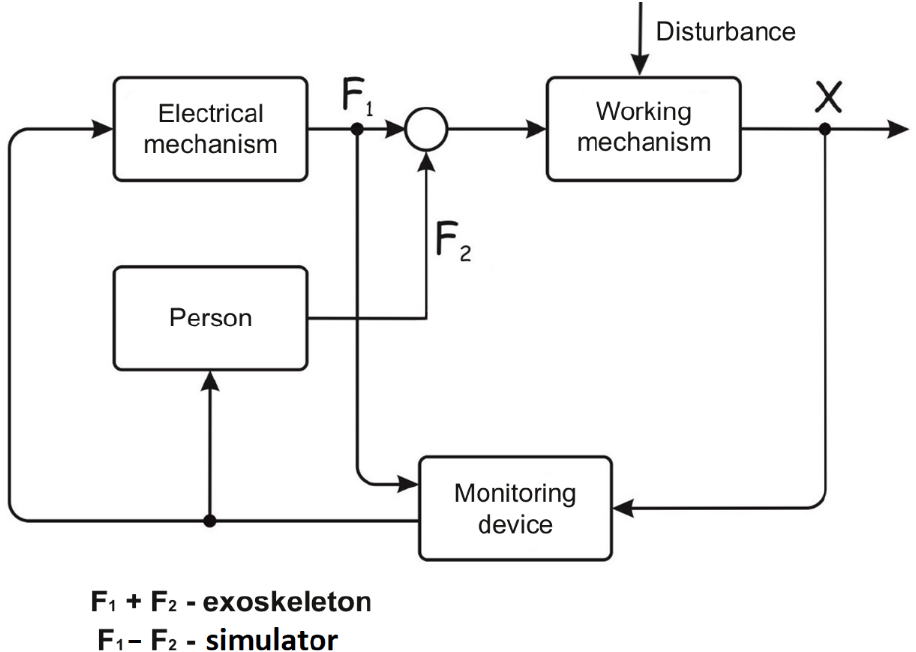
Figure 2. Structural diagram of the system of force interaction between a person and a “machine” with external disturbing factors.